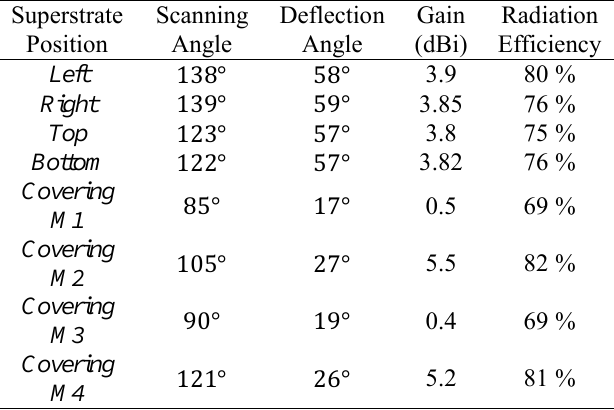
Table 2. Experimental Study by shifting the superstrate above the driven